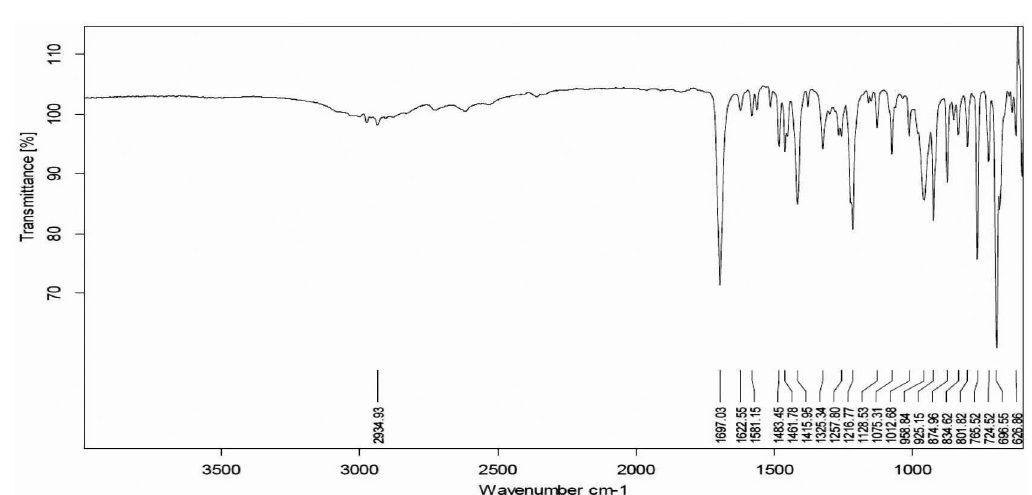
FIGURE 1 - FTIR spectrum of flurbiprofen.